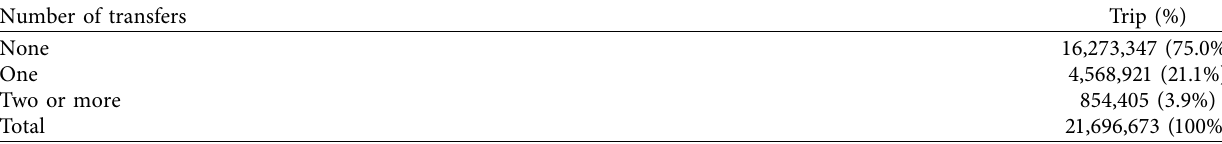
Table 2: Number of transfers per day